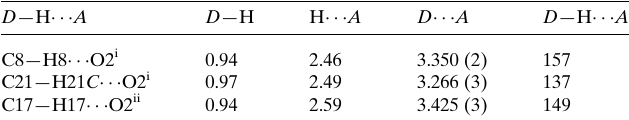
Table 1 Hydrogen-bond geometry (A˚ , (cid:2) ).